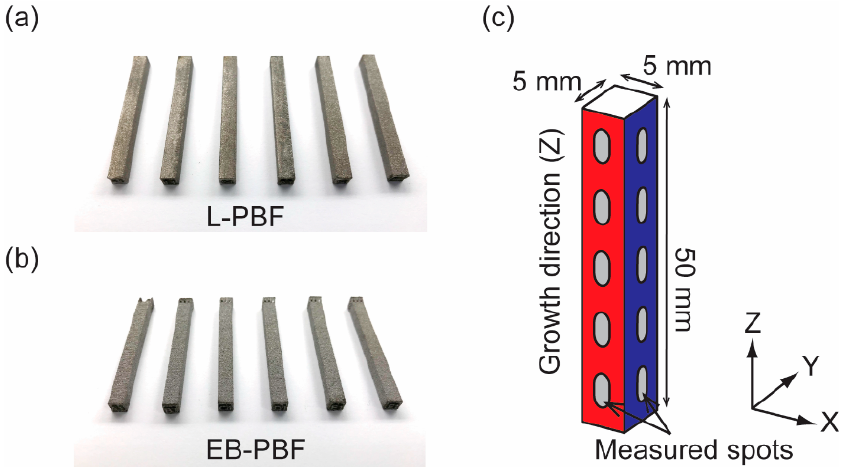
Figure 1. ( a ) Appearance of L-PBF-made parts. From the left, L-PBF-360W-Fast-X, XY, Rot, L-PBF-75W-Slow-X, XY, Rot; ( b ) The appearance of EB-PBF-made parts. From the left, EB-PBF-900W-Slow-X, XY, Rot, EB-PBF-750W-Fast-X, XY, Rot; ( c ) Measurement locations are shown with the part dimensions, coordinate axes, and layer growth direction. Each of the “measured spots” is 4 mm long in the Z direction and 1–3 mm wide in the X or Y direction, depending on the X-ray incident angle.